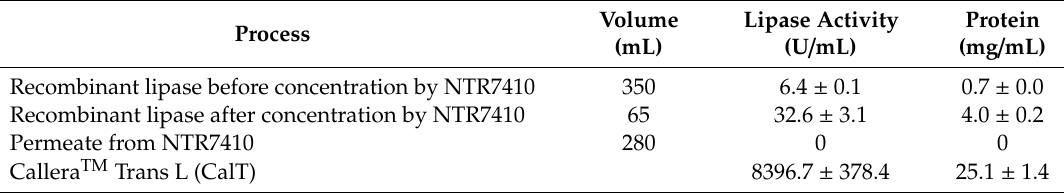
Table 1. Comparison of lipase activity and protein